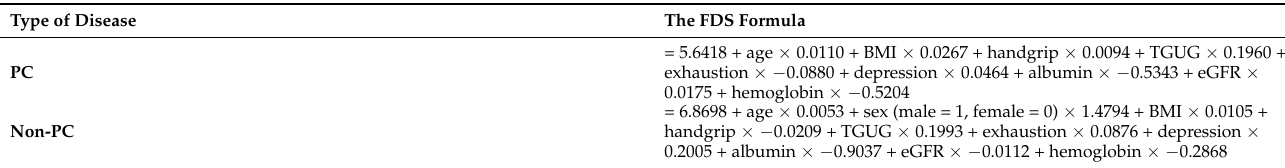
Table 1. The FDS formulas for patients with PC and